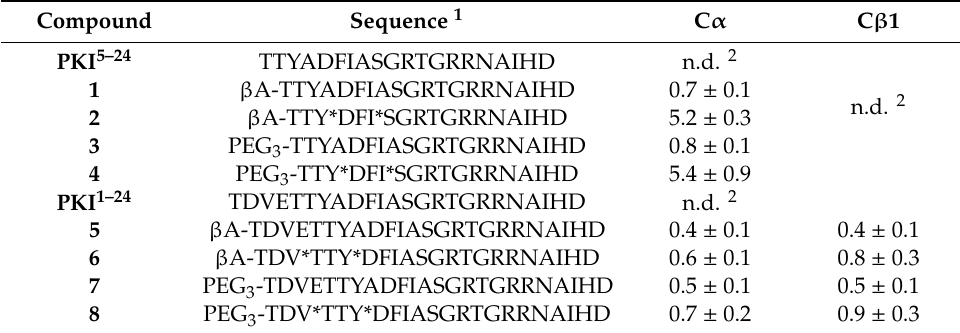
Table 1. IP20 Analogs developed as potential pseudosubstrate inhibitors for the catalytic subunit of Protein Kinase A (PKA-C) and summary of measured binding a ffi nities (K D , [nM]) of peptides towards the human PKA catalytic isoforms C α and C β 1 as measured by fluorescence polarization (FP). Mean values of three independent measurements are